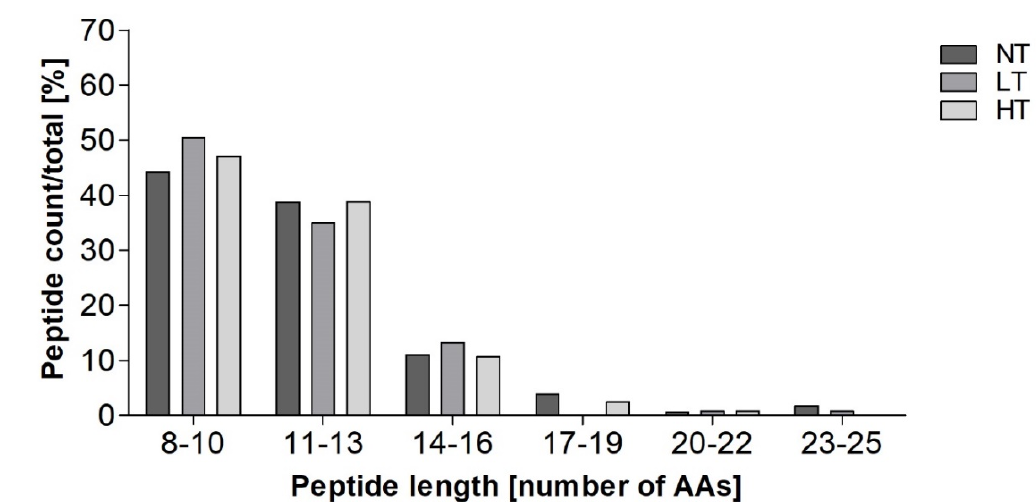
Figure 4. Peptide length distribution on the basolateral side of digestion-derived peptides, sampled after 10 min in the intestinal phase from simulated infant in vitro digests of cow’s milk protein, non-treated (NT), heated in the presence of lactose at low temperature (LT), and high temperature (HT), expressed as peptide count relative to the total number (NT: 181, LT: 129, HT: 121) of peptides in one sample.